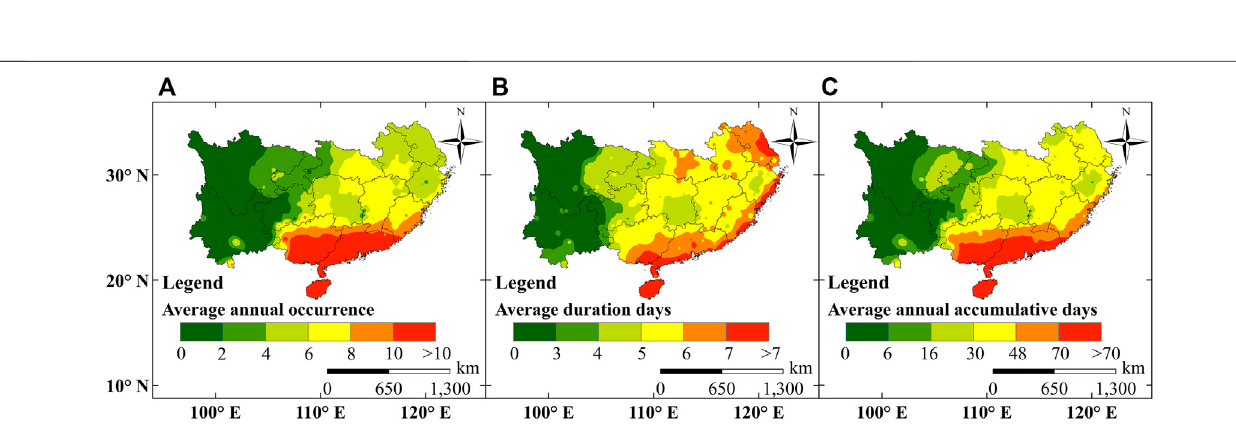
FIGURE2| |ObservationandsimulateddailyaverageRH (A) andmaximumtemperature (B) inplasticgreenhousesbytheELMmethod. n isthesamplesizeforthe testing stage.